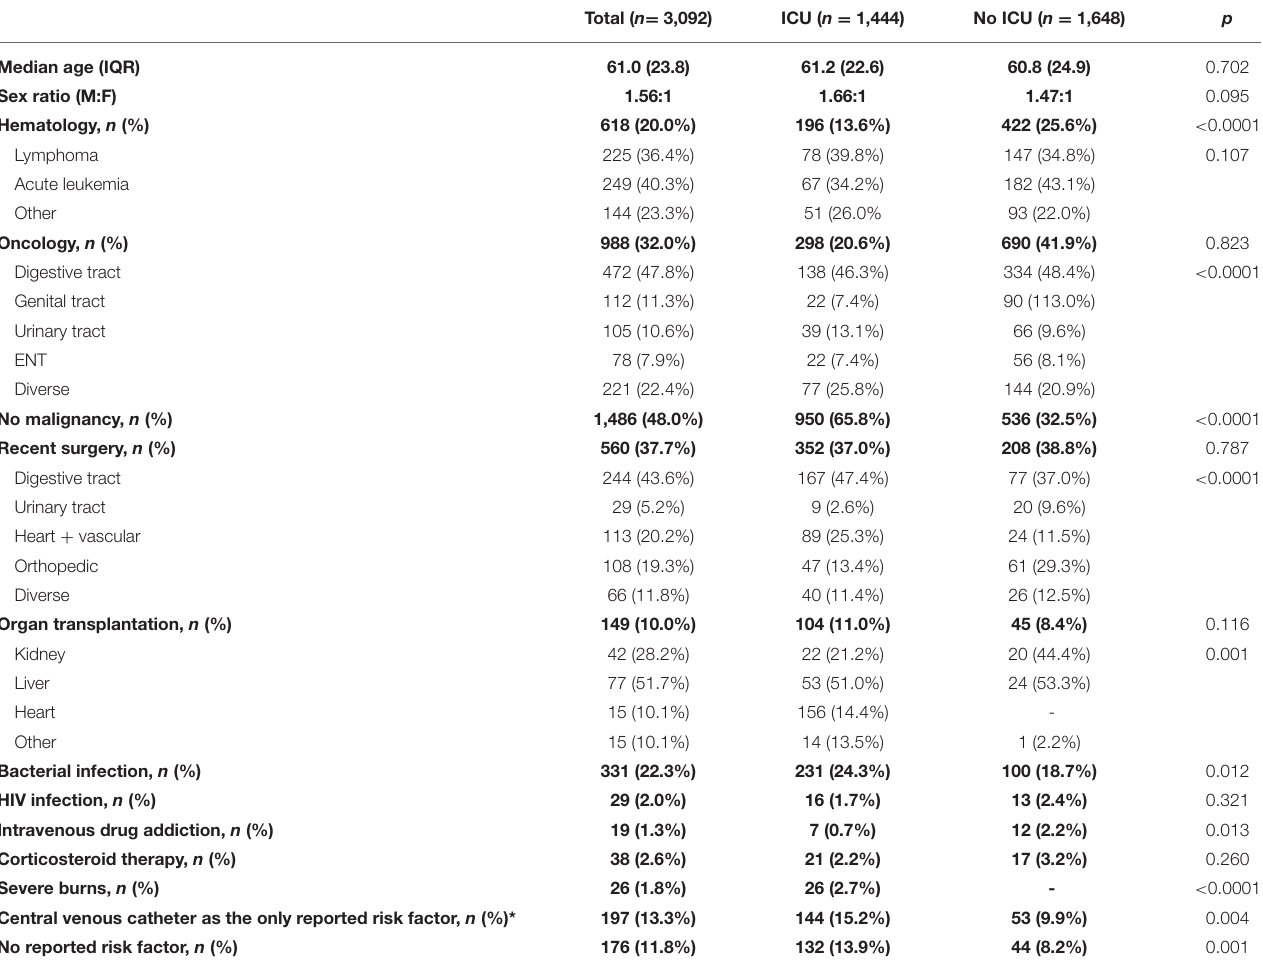
TABLE 1 | Characteristics of the 3,092 patients who experienced a first episode of yeast fungemia (Paris, YEASTS program,